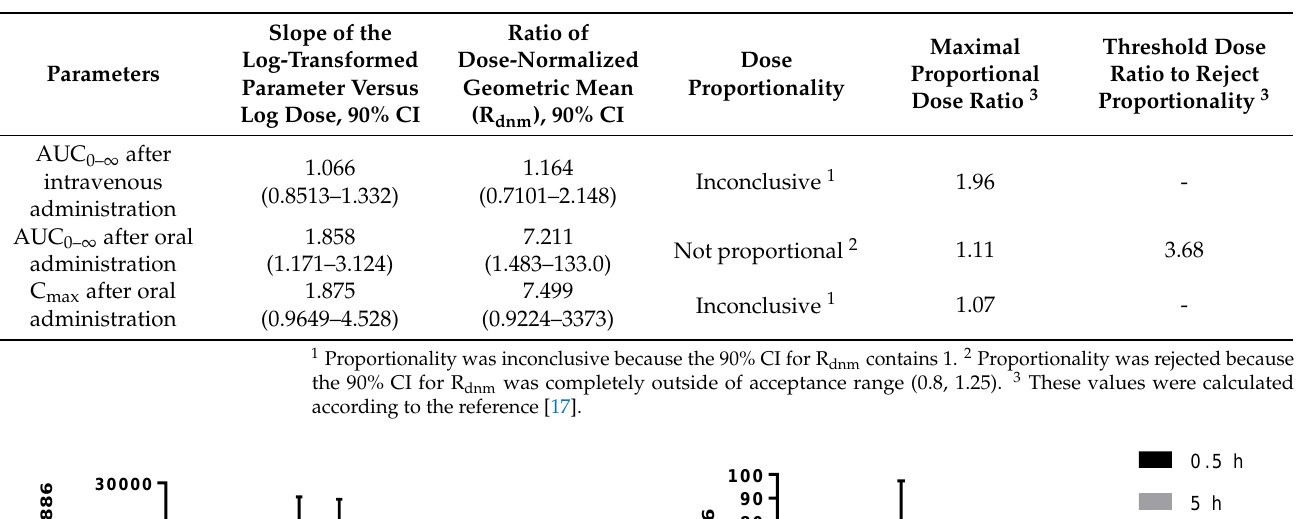
Table 4. Dose proportionality assessment of DA-6886 after single intravenous and oral administration at doses of 2, 10, and 20 mg/kg to rats.